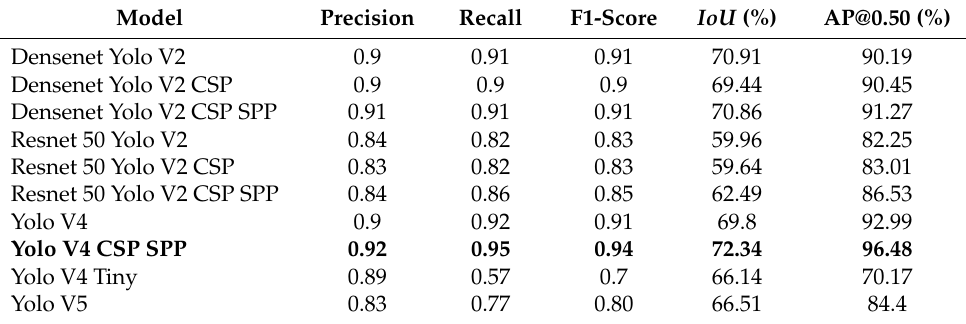
Table 3. Testing performance using Oxford hand